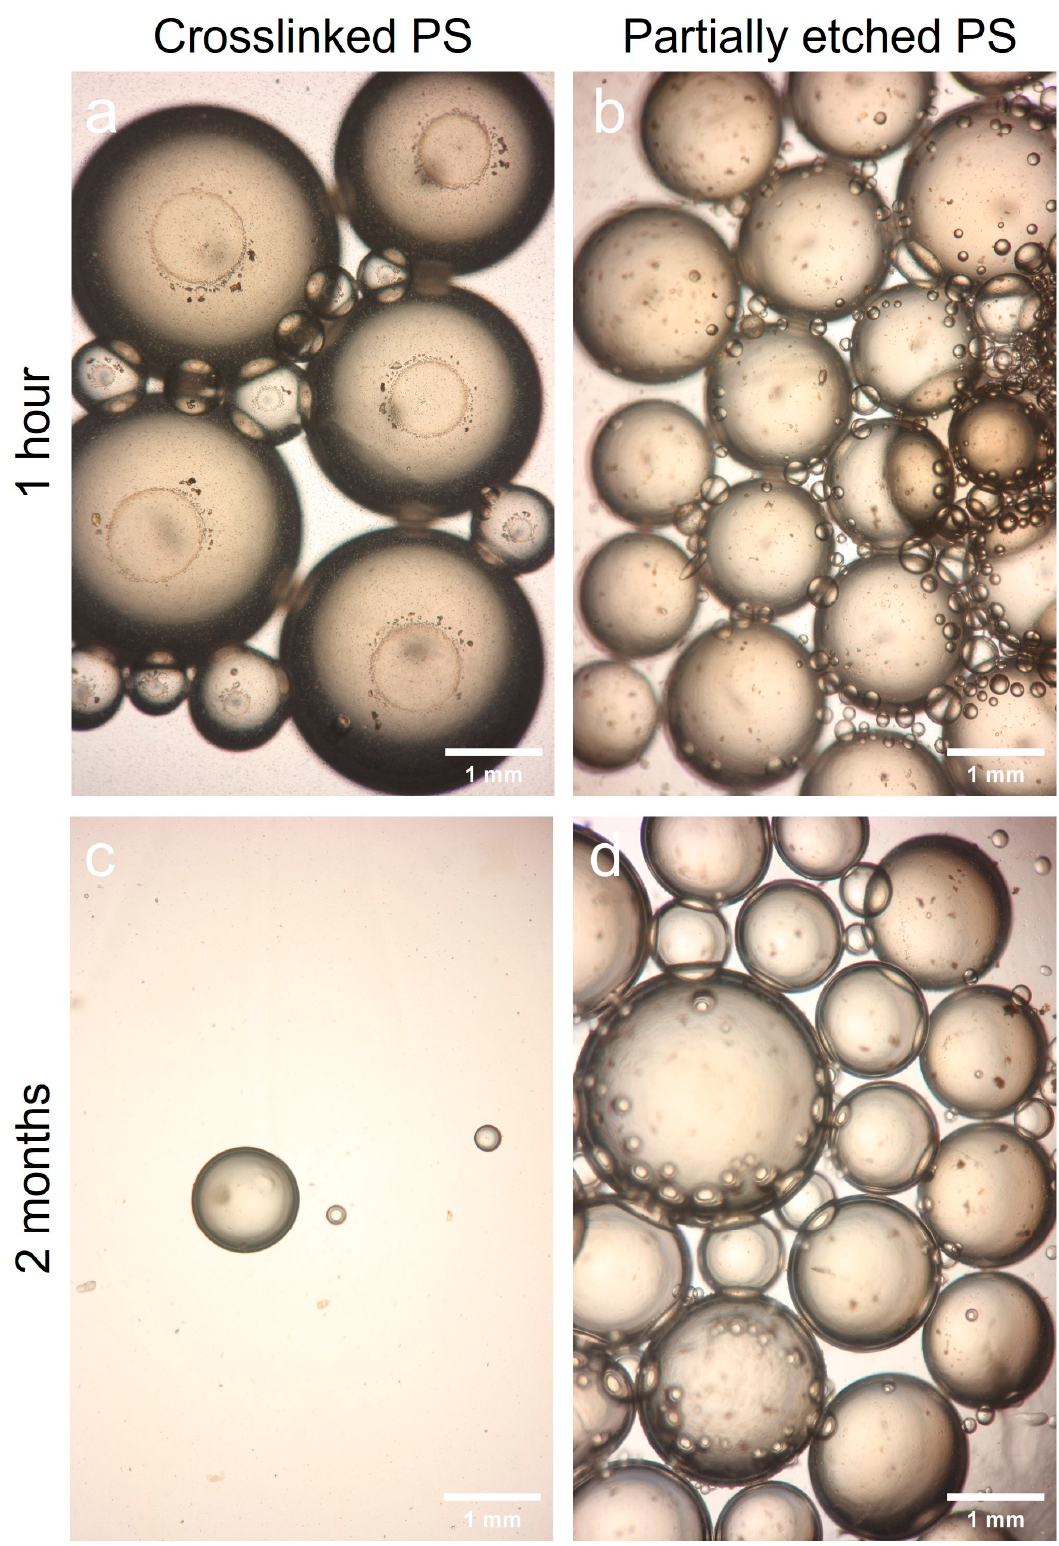
Figure 5. Microscopic images showing the Pickering emulsion stability formed with spherical PS NPs ( 𝑡 (cid:3005)(cid:3023)(cid:3003) = 0 min sample shown in Figure 3c) ( a , c ) and partially etched PS NPs ( 𝑡 (cid:3005)(cid:3023)(cid:3003) = 70 min sample shown in Figure 3c) ( b , d ). sample shown in Figure 3c) ( b , d